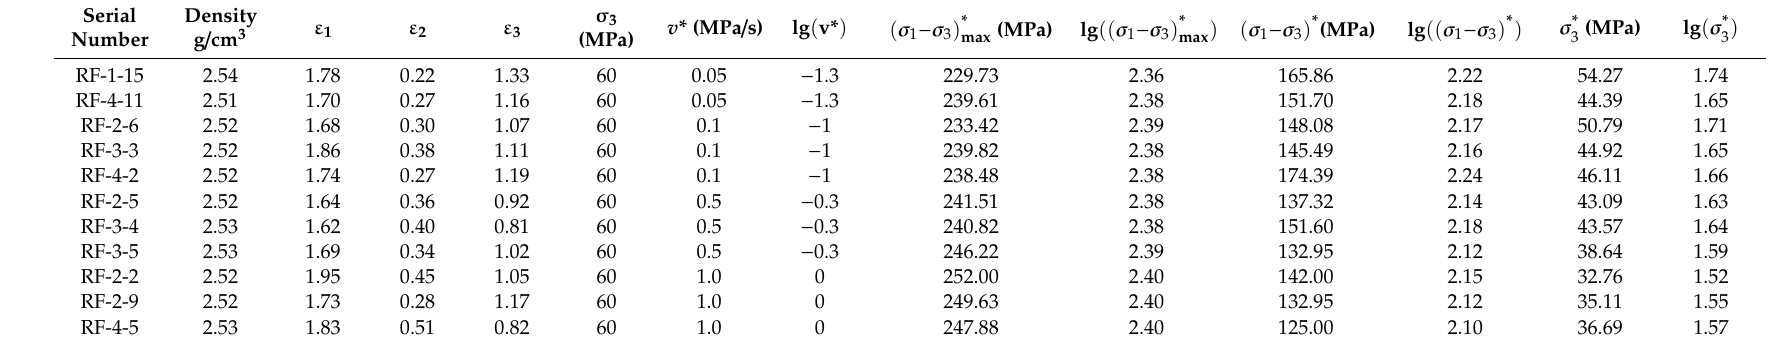
Table 1. Experimental plan and related